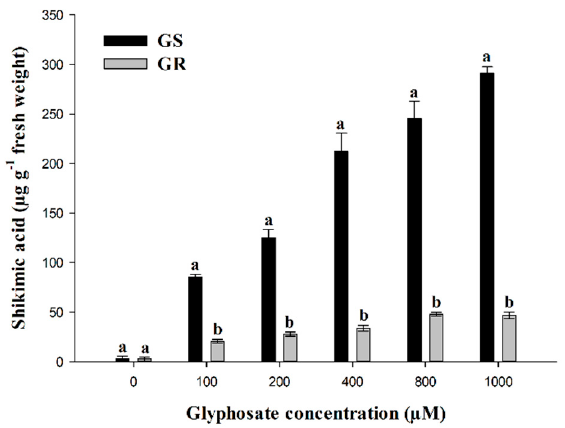
Figure 2. Shikimic acid accumulation in plant leaves of susceptible (GS) and resistant (GR) C. distichophylla populations. Symbols denote the means ( n = 3), vertical bars correspond to standard errors of the mean.